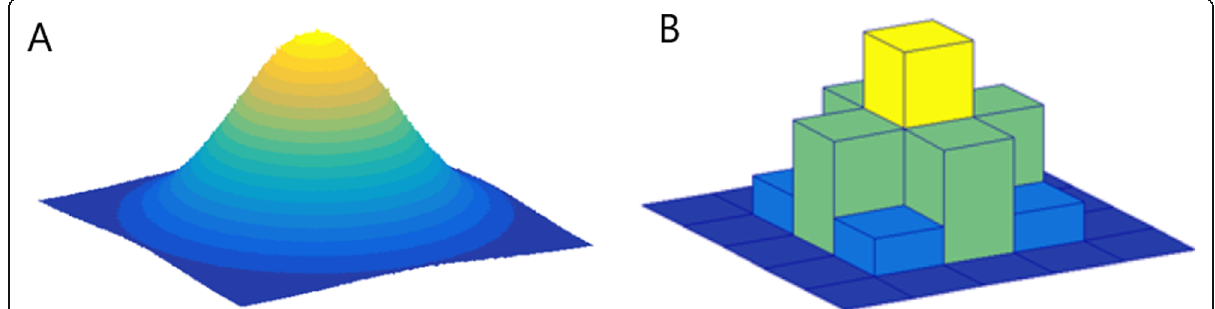
Fig. 2 Image intensity discretization. Original data ( a ) and a generic discretized version ( b